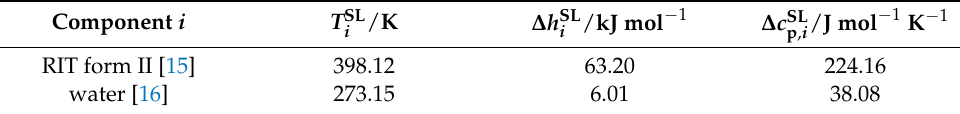
Table 1. Pure-component properties of RIT form II and of water at 0.1